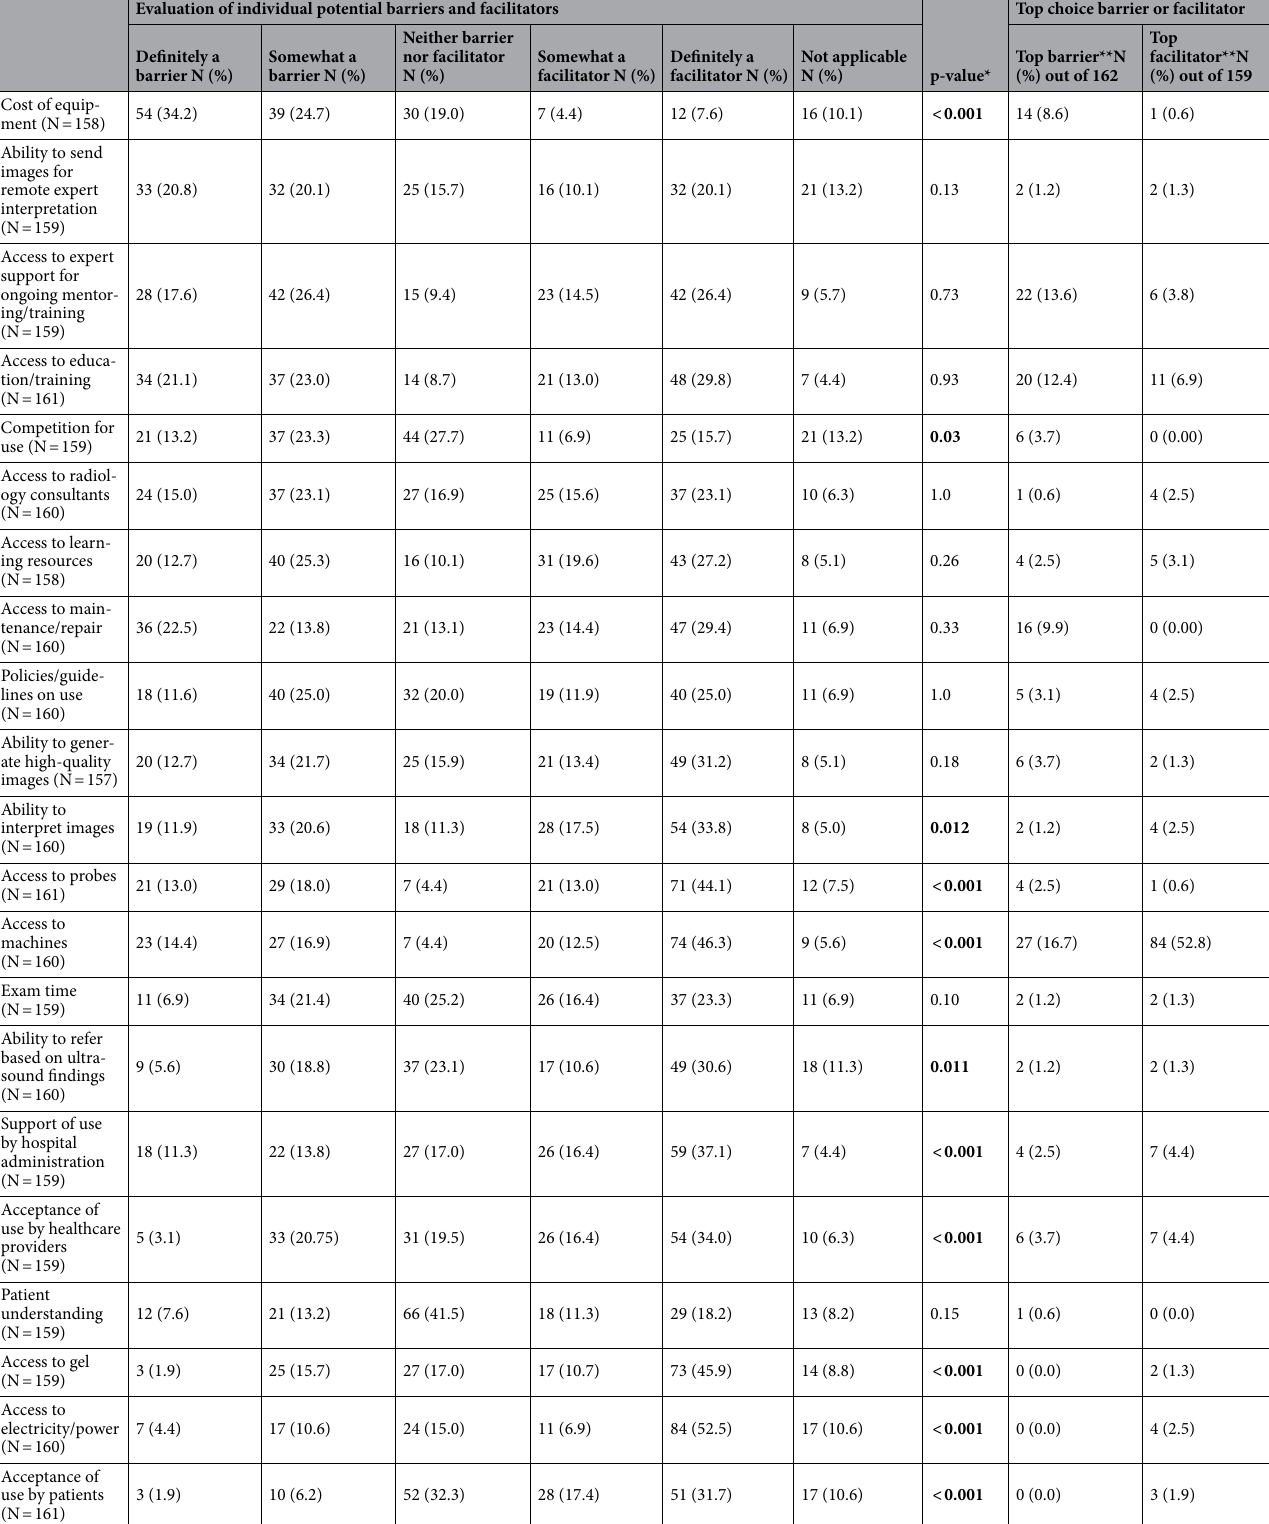
Table 4. Barriers and facilitators to ultrasound use in low- and middle-income countries. *p-value comes from combining definitely a barrier with somewhat a barrier and combining definitely a facilitator with somewhat a facilitator for each row, leaving out neither barrier nor facilitator and not applicable, and performing an exact binomial test to determine whether the proportion of barriers for each row is different from 0.50. Significant values are in bold. **N reported includes not applicable (N/A) responses. For top barrier, 14 respondents answered N/A; for top facilitator, 7 respondents answered